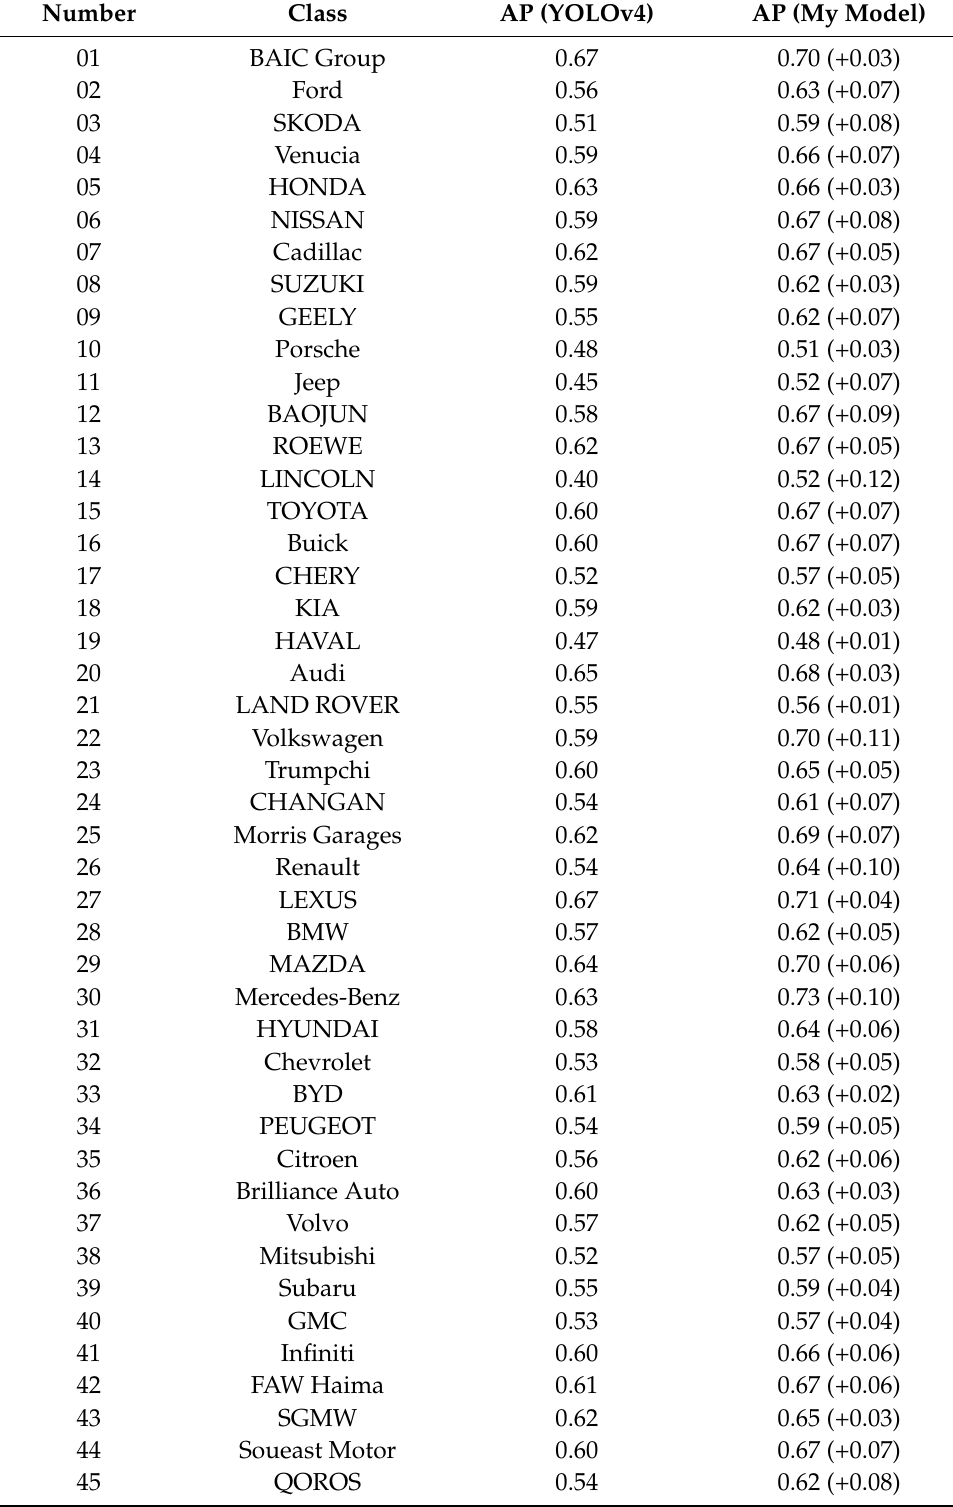
Table 2. AP values of YOLOv4 and improved YOLOv4 in various